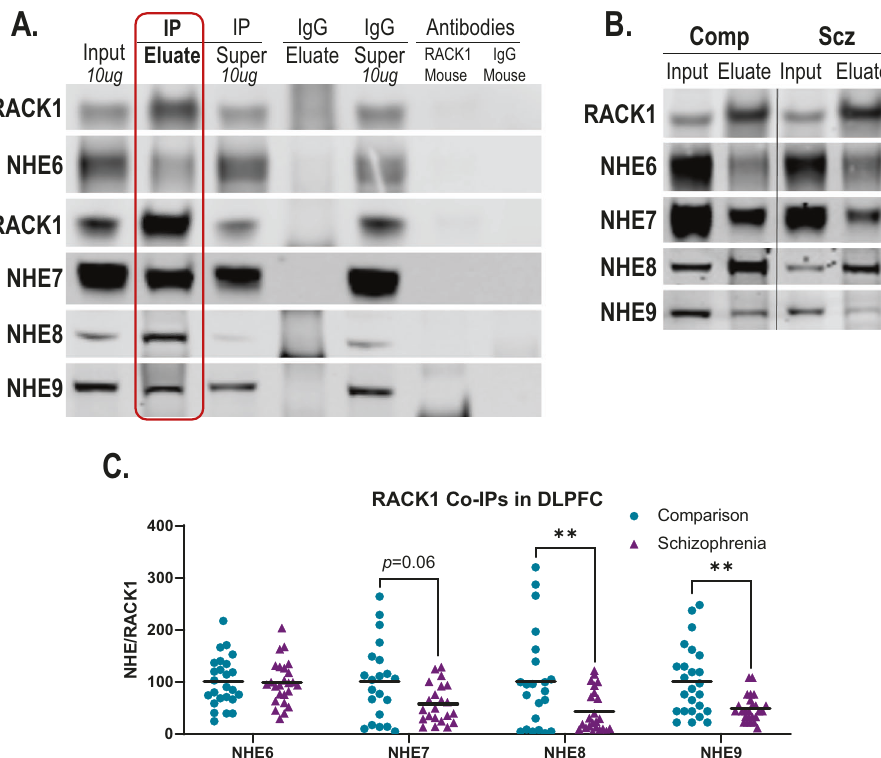
Fig. 3 NHE association with RACK1 in schizophrenia dorsolateral prefrontal cortex (DLPFC). A Representative Western blots for RACK1 and NHE6 as well as RACK1 and NHE7-9 following co-immunoprecipitation (co-IP) with RACK1 antibody in human cortex. Co-IP of RACK1 enriches for RACK1 in IP eluate. NHE6-9 are all present in the RACK1 co-IP eluate suggesting interactions between these transporters and RACK1 in human cortex. No RACK1 enrichment was seen in a control co-IP with pre-immune, non-speci fi c mouse IgG, demonstrating the speci fi city of co-IP with RACK1 antibody. In addition, RACK1 antibody and IgG alone did not produce immunoreactive bands at the molecular weights (MWs) of our assayed proteins. B Representative Western blots probing for RACK1 and NHE6-NHE9 in SZ and COMP DLPFC. C Quanti fi cation of NHE6-NHE9 normalized to intralane RACK1 in RACK1 IP eluate demonstrates decreased association between NHE8/NHE9 and RACK1 in SZ DLPFC with a nonsigni fi cant decrease in NHE7 association with RACK1 between groups ( p = 0.06). Lines represent group means. ** p < 0.01. IP immunoprecipitation, Super supernatant, IgG immunoglobulin G, COMP comparison, SZ schizophrenia, co-IP